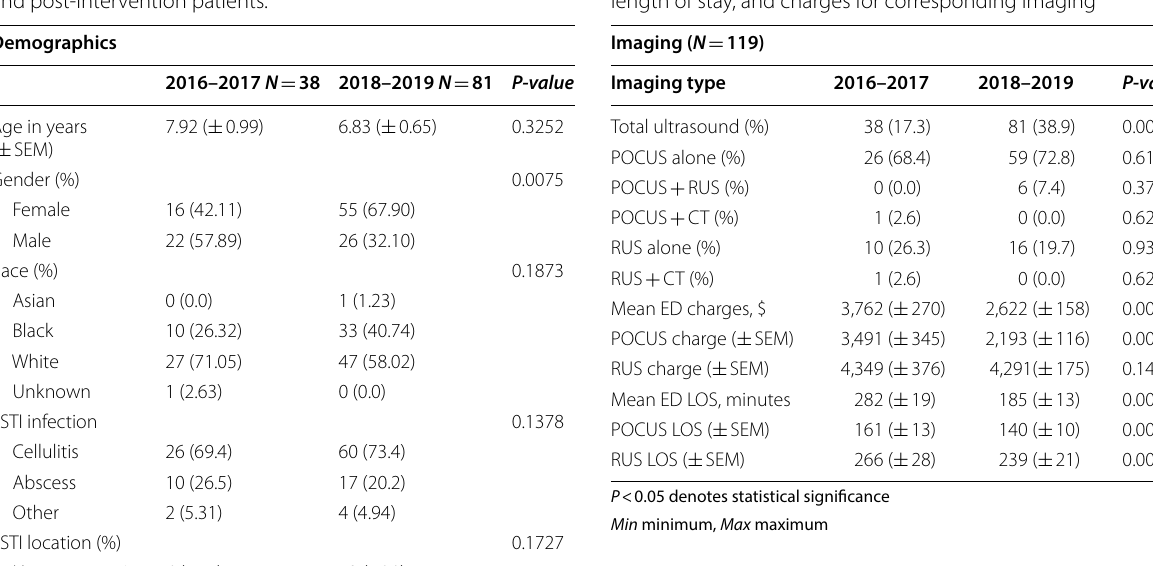
Table 1 Demographics and characteristics of SSTI between pre- and post-intervention patients.